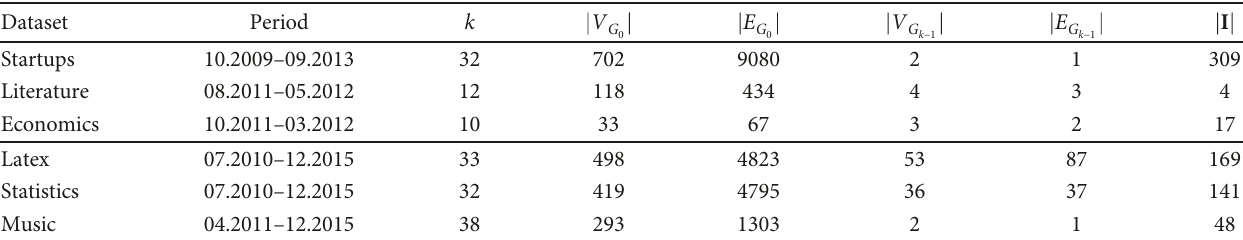
Table 2: Description of the datasets used and the k constructed networks over the given period. The initial network is G . The number of the extracted cascades is I . is G k − 1